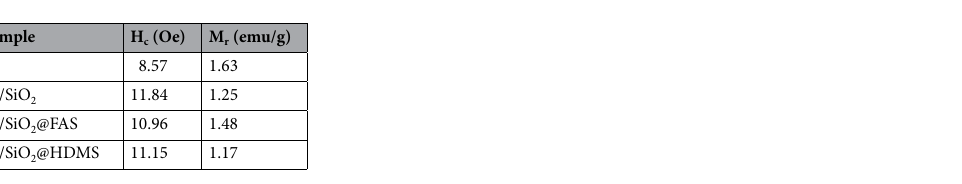
Table 1. Summary of magnetic properties of bare CI, SiO 2 , SiO 2 @FAS, and SiO 2 @HDMS.